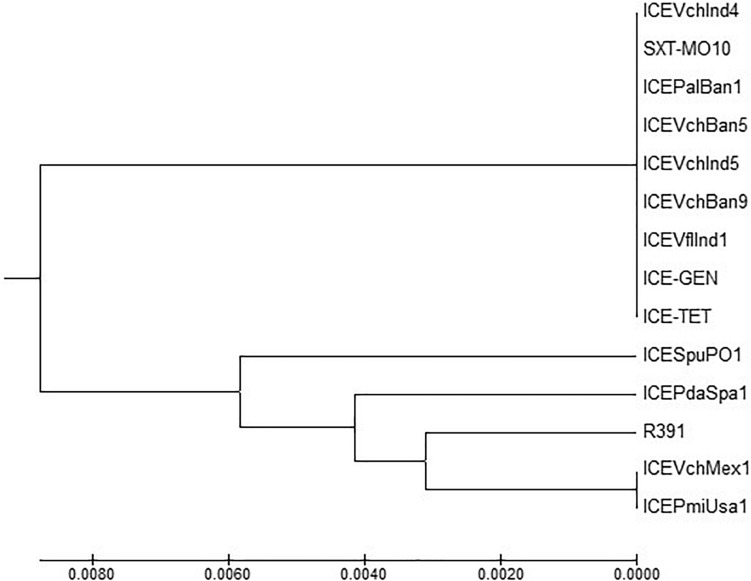
MEGA7 analysis based (Kumar et al., 2016) evolutionary relationships of taxa of setR of V. cholerae O1 strains.